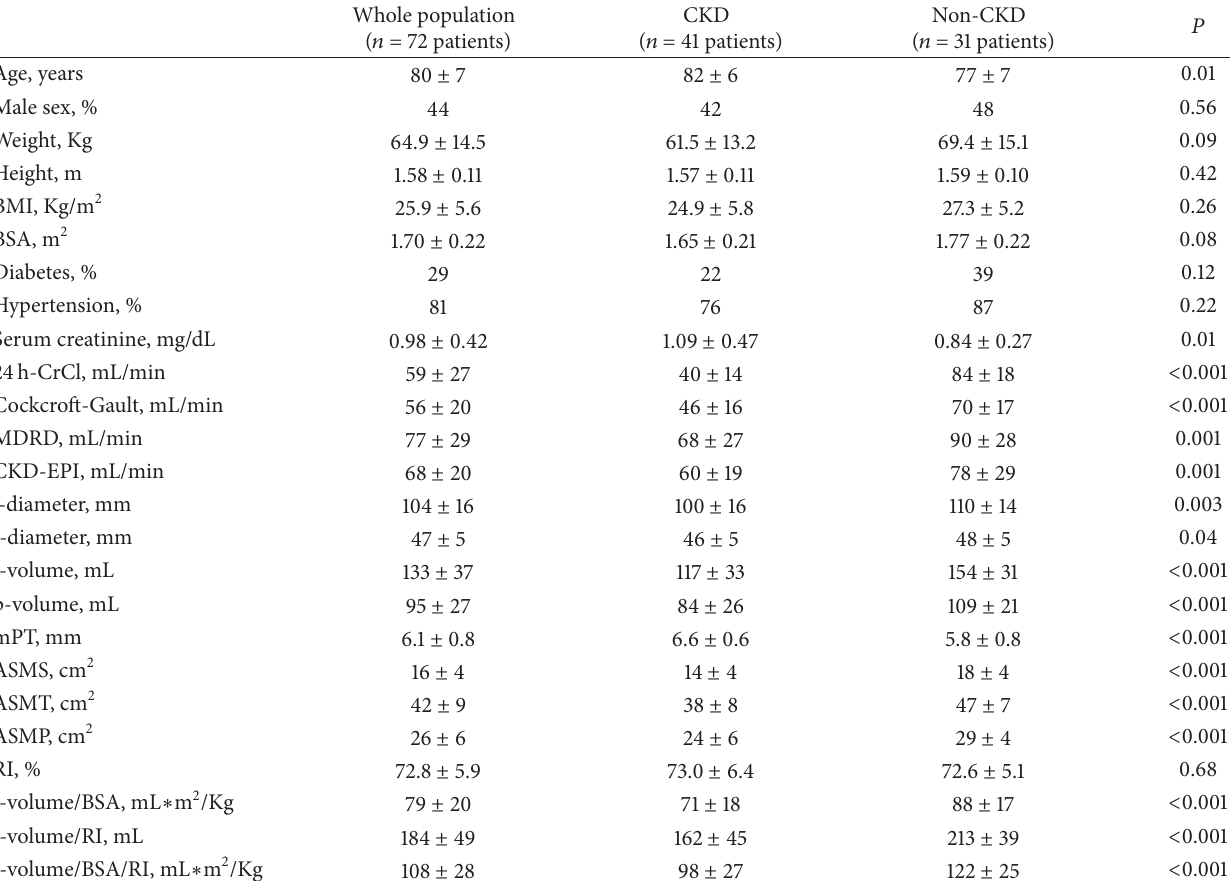
Table 1: Demographic and clinical